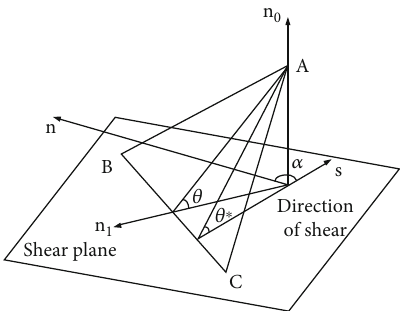
Figure 5: Geometrical relationship diagram of jointed elementary apparent dip